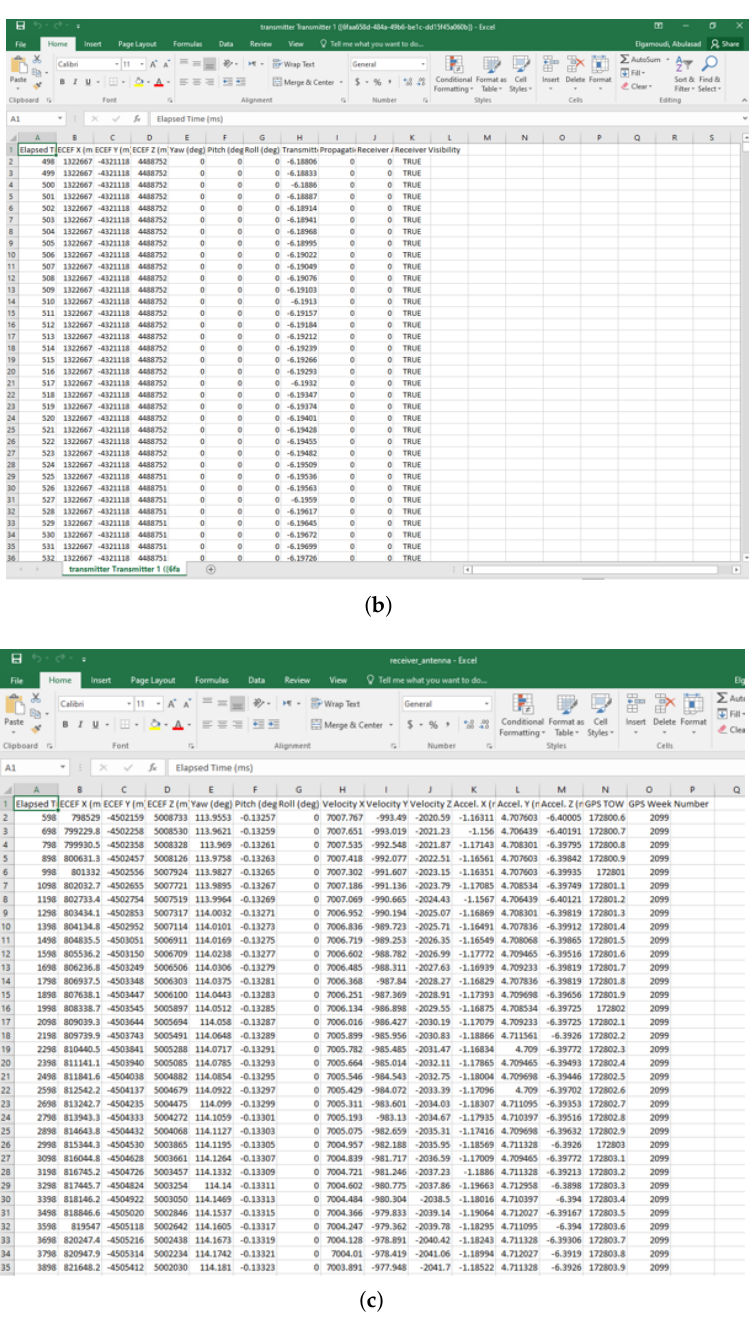
Figure A1. Log files generated by Orolia used for geolocation and tracking measurements. ( a ) An- tenna.CSV. ( b ) Transmitter.CSV (UAV). ( c ) Receiver.CSV (LEO